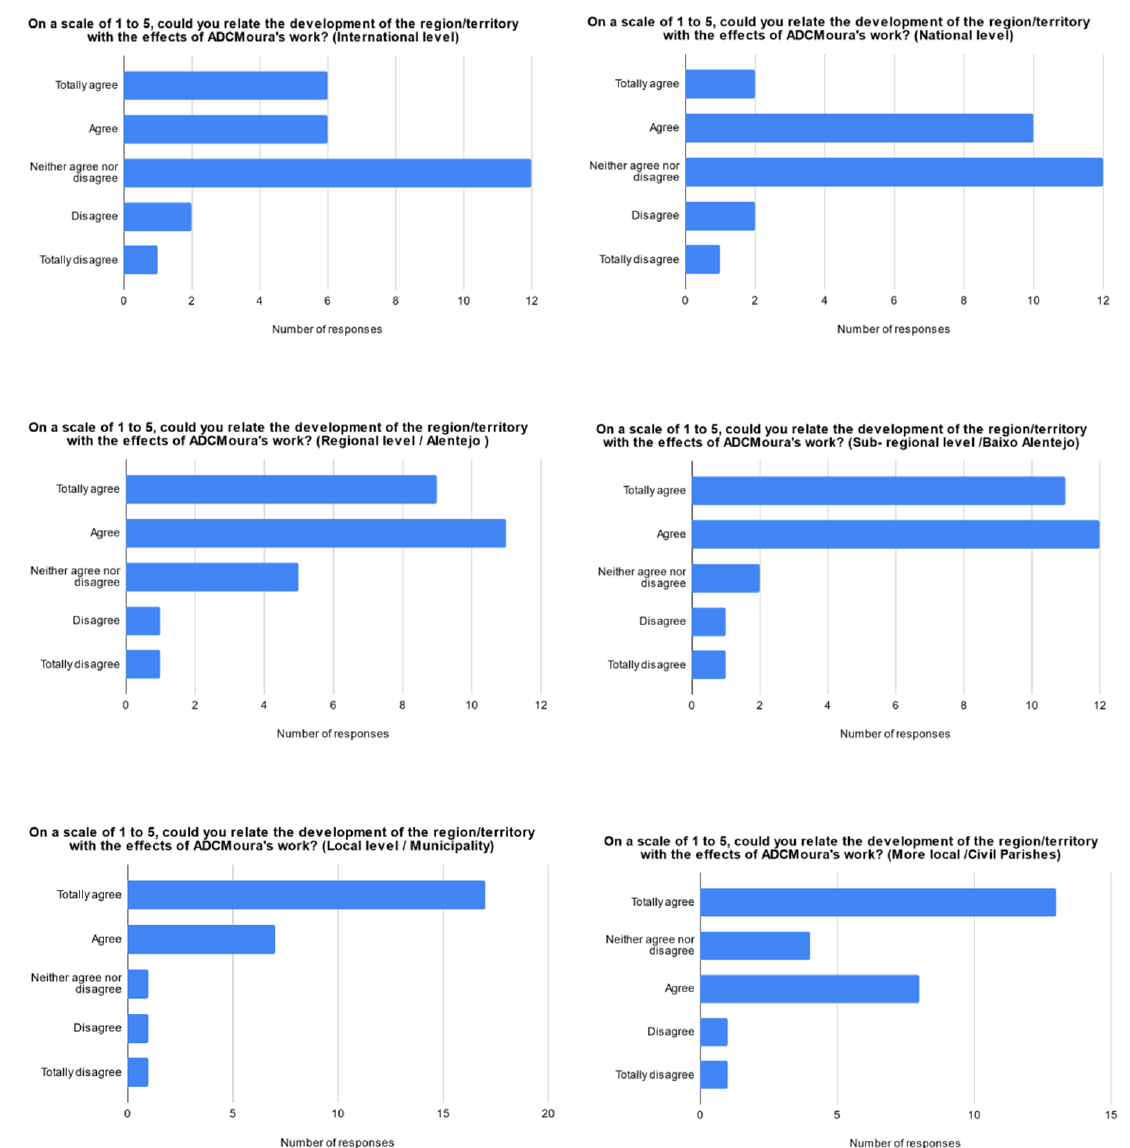
Figure 7. Spatial scale of SI impacts. Source: author’s own elaboration.